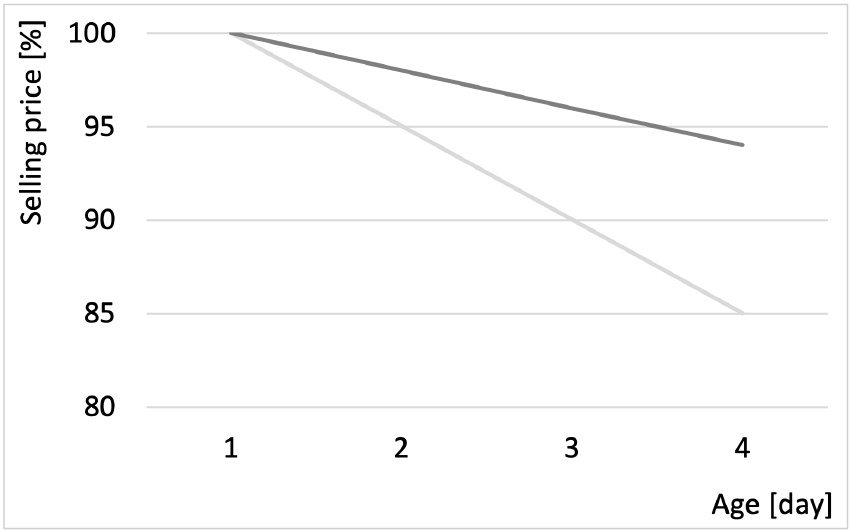
Figure 1. Selling price variation of broccoli and artichokes according to age.